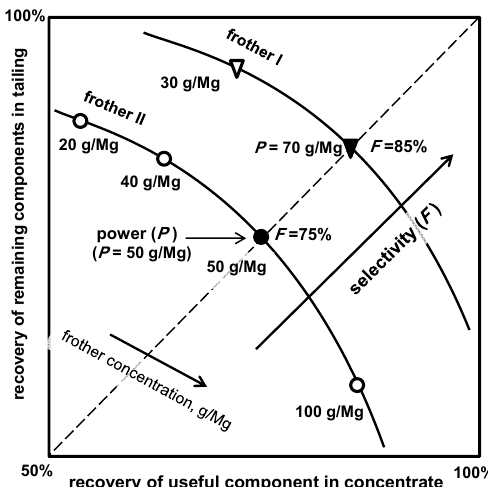
Figure 15. Procedure of determination of selectivity F (%) and separately power P (expressed in frother dose) of flotation frothers using the Fuerstenau upgrading curve [76]. Collector, if used, regulates hydrophobicity and its concentration is constant.